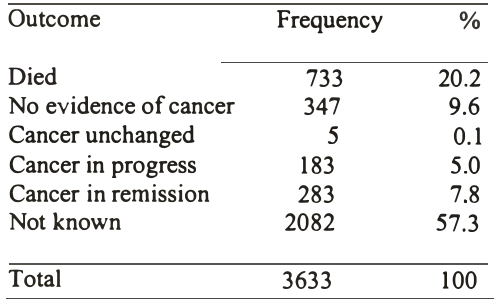
Table 9: Distribution by outcome Outcome Frequency